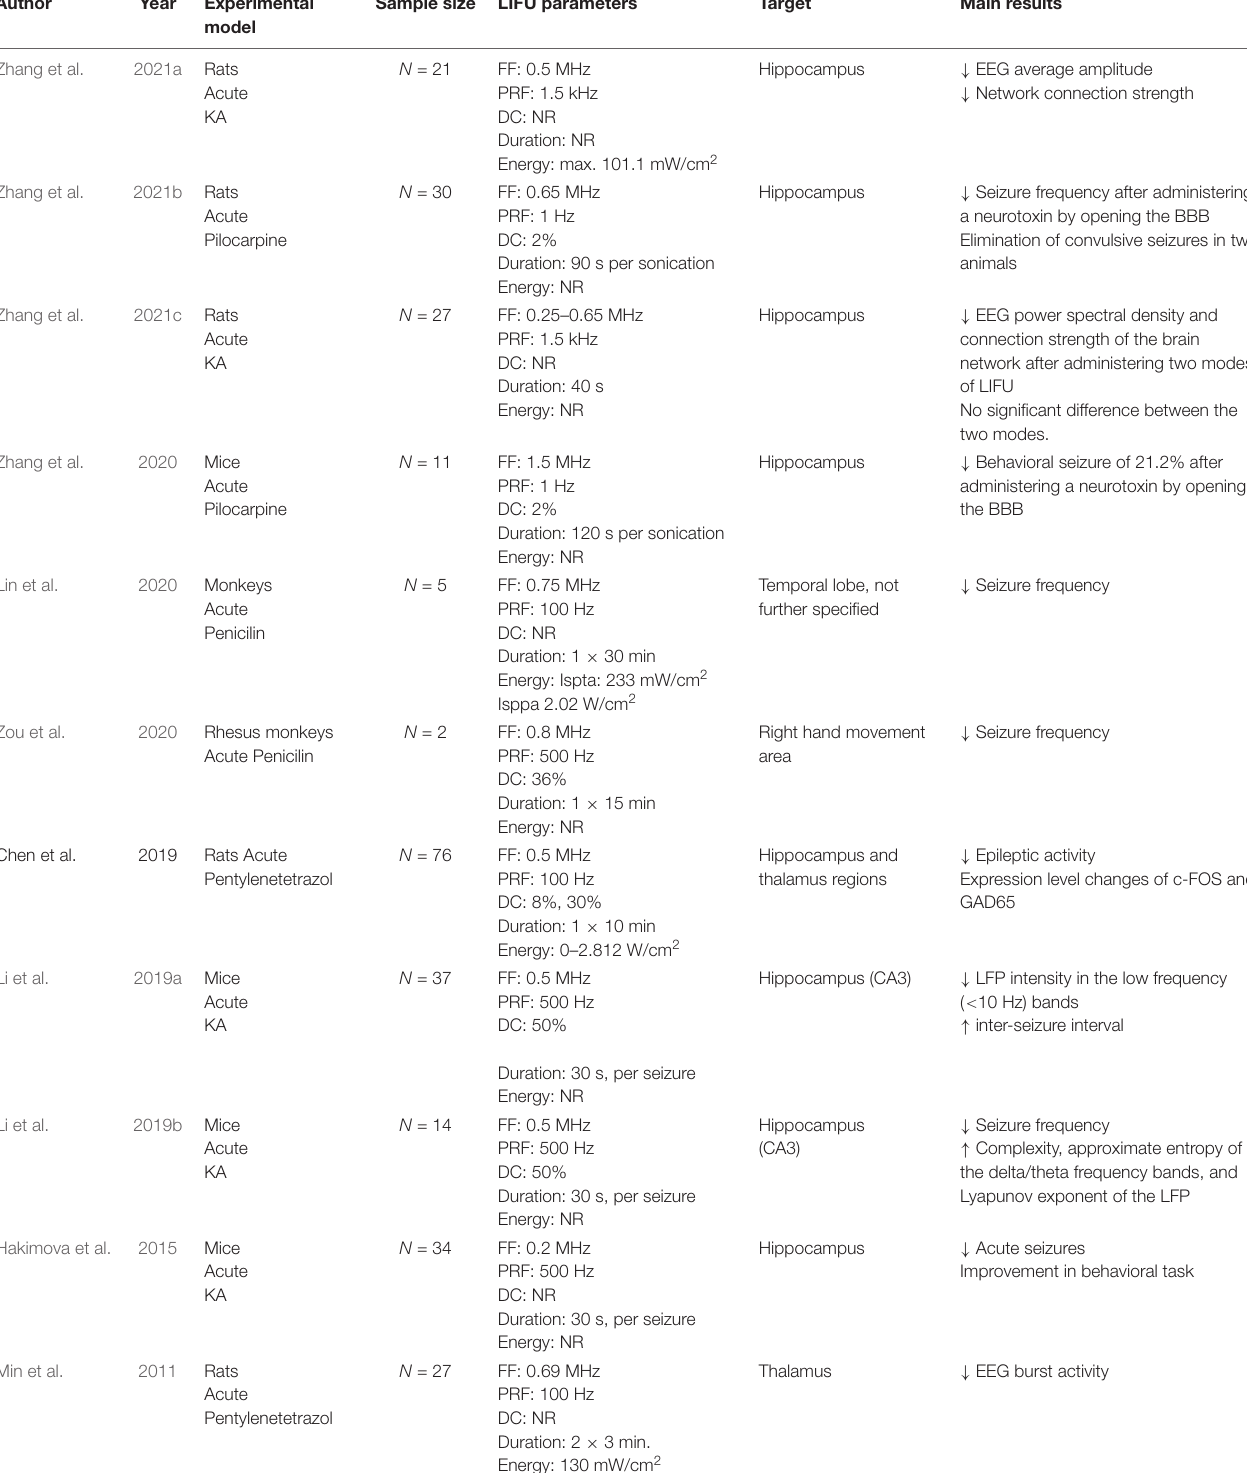
TABLE 3 | Schematic overview of preclinical trials investigating behavioral and neurophysiological effects of LIFU in experimental epilepsy